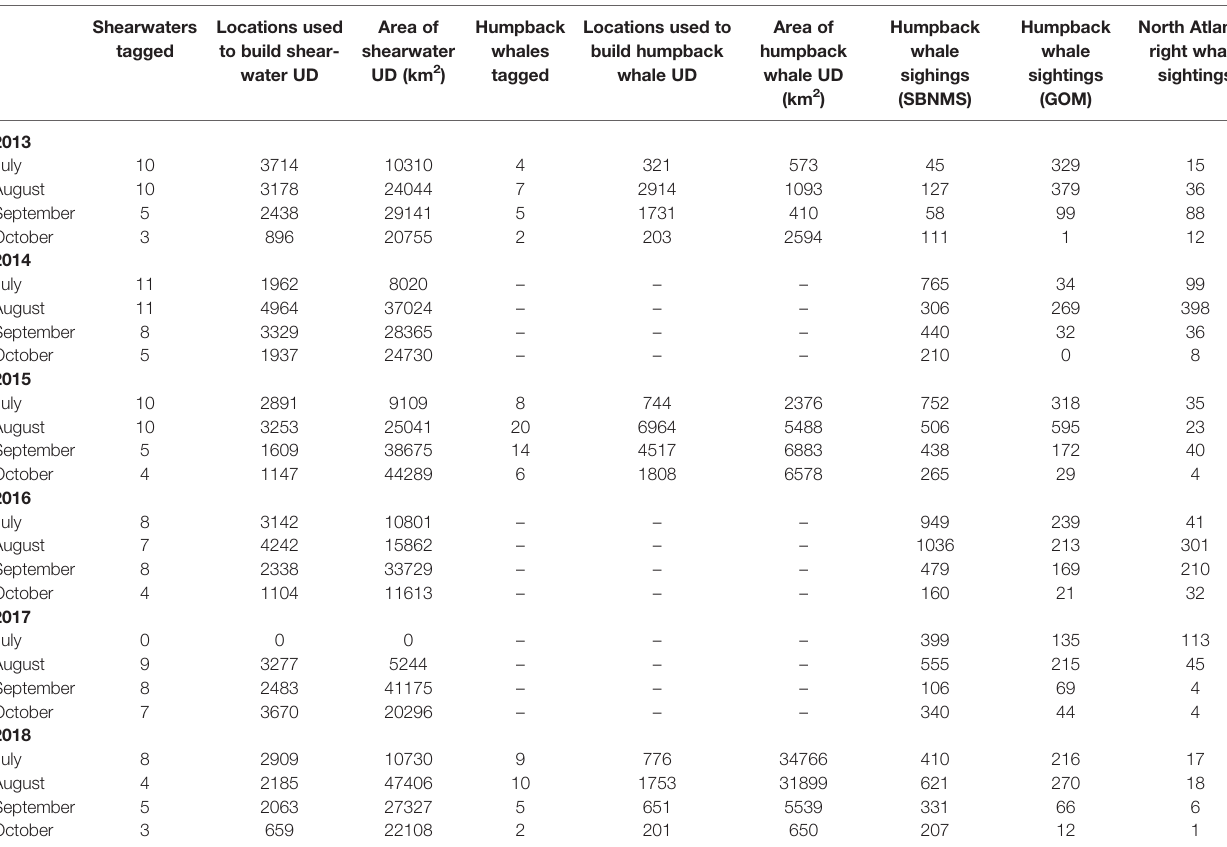
TABLE 2 | Tagging and sightings data summaries used in monthly calculations for each month 2013-2018. Shearwaters Locations used tagged to build